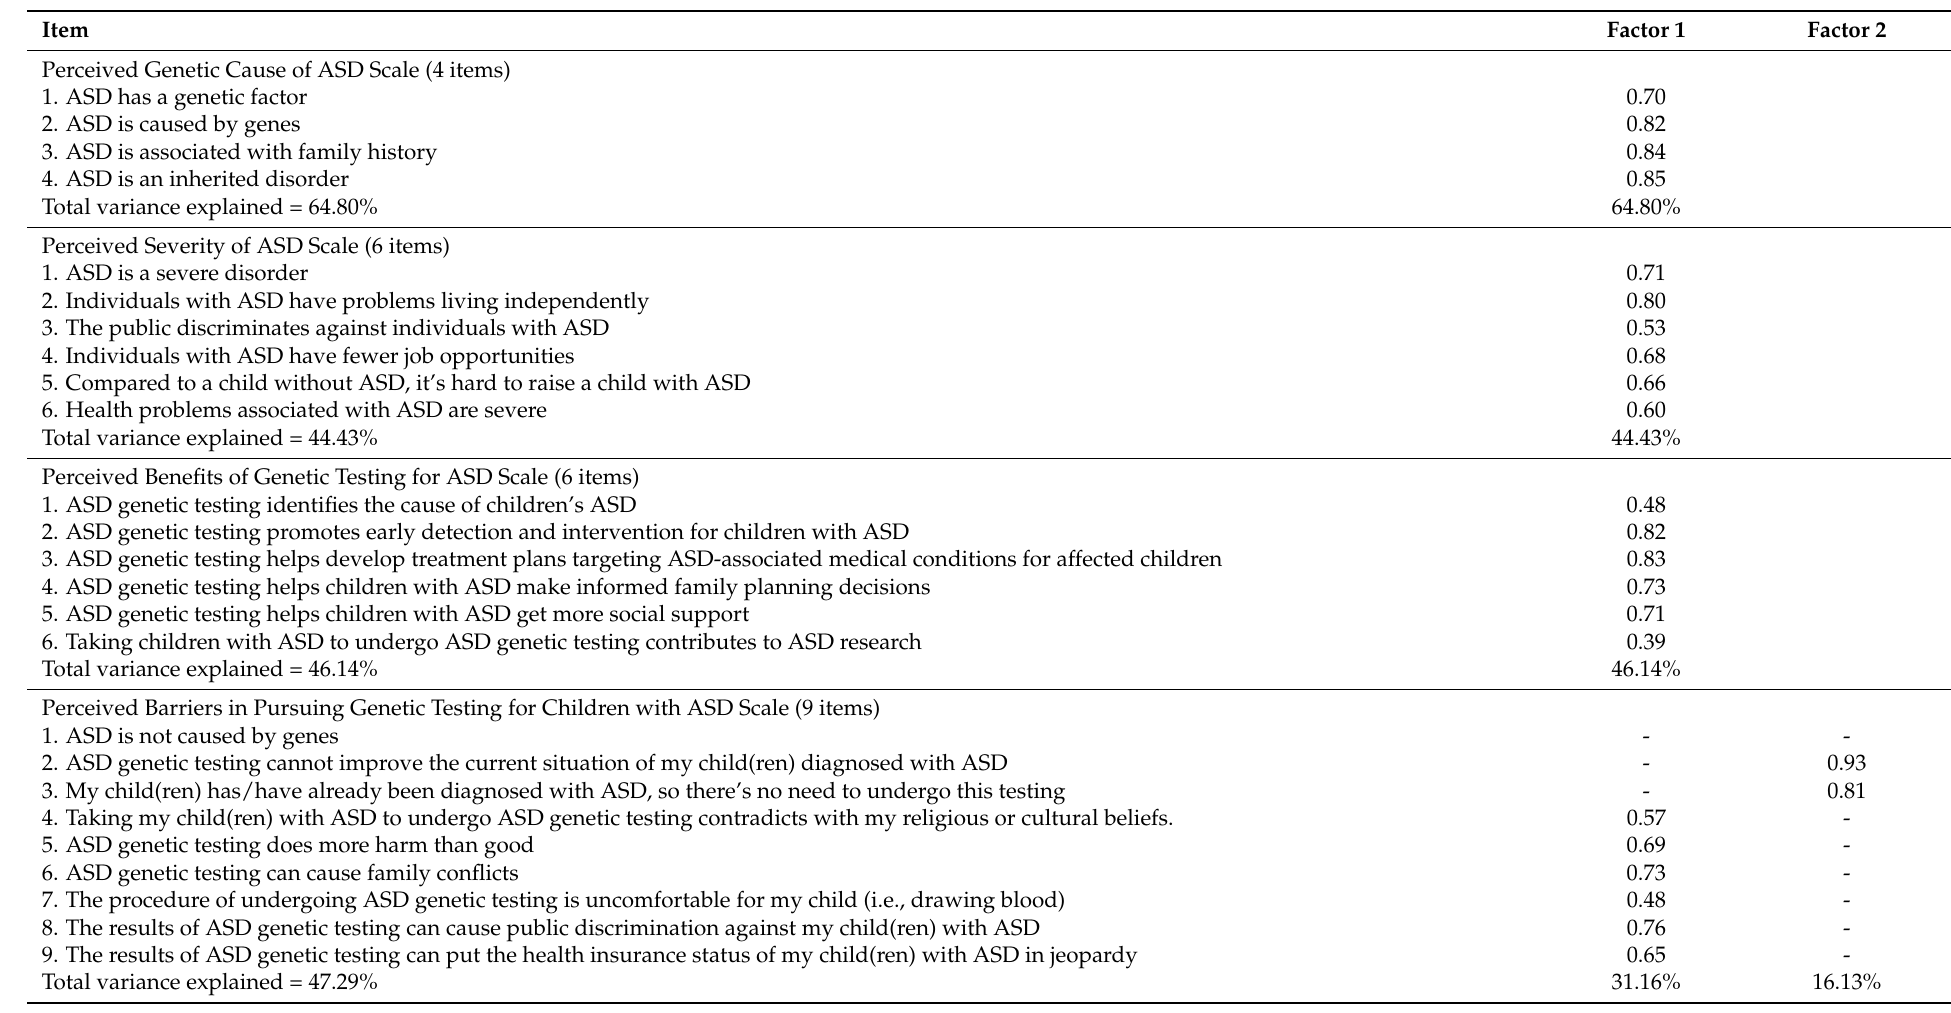
Table 2. Factor loadings for exploratory factor